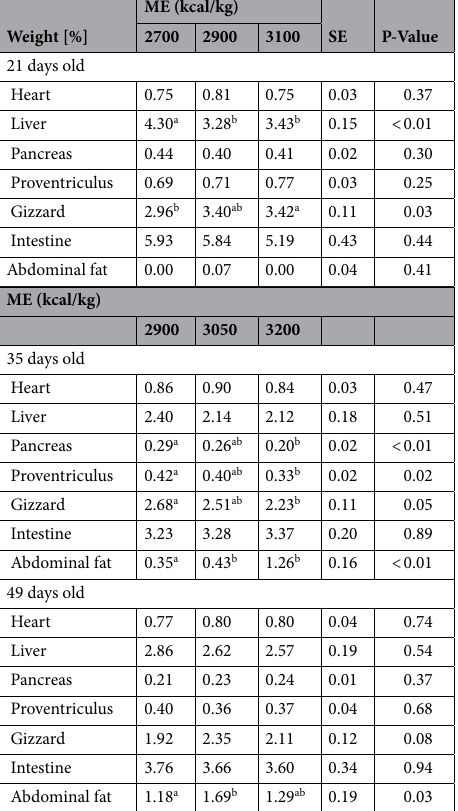
Table 3. Relative weights of organs, intestine and fat abdominal as a function of metabolizable energy levels (ME) in the diet and production phase of European quail meat. SE: Standard error of the mean; Means followed by distinct letters in the lines differ from each other by Tukey’s test at 5%